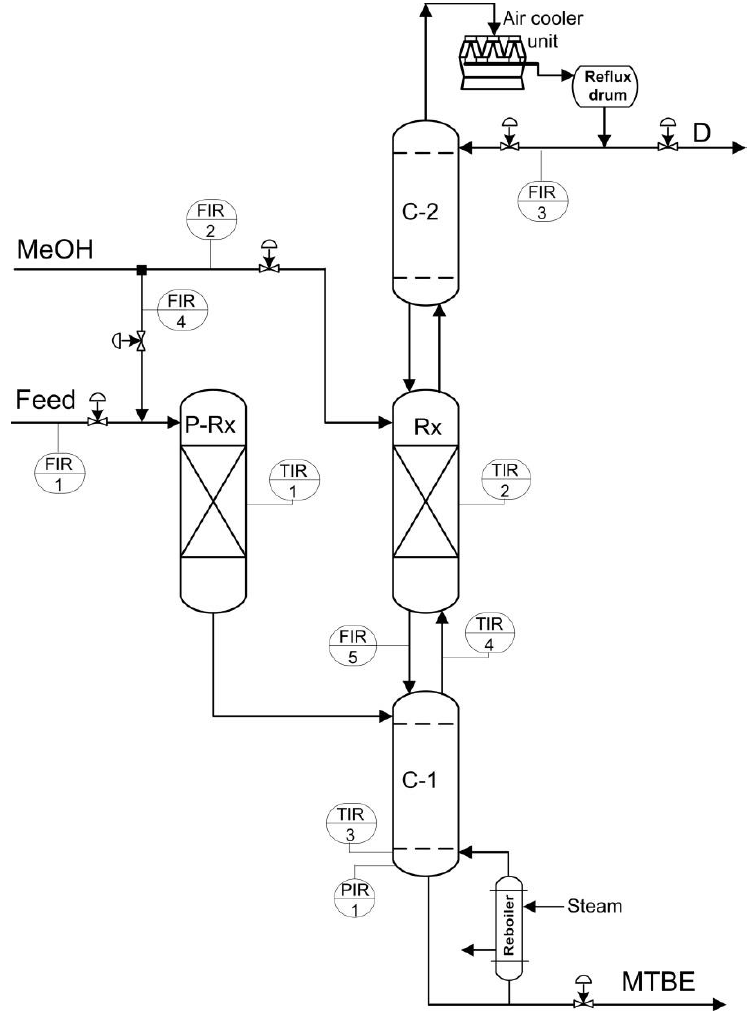
Figure 3. Reactive distillation unit of MTBE production. Table 1. Soft sensor input and output